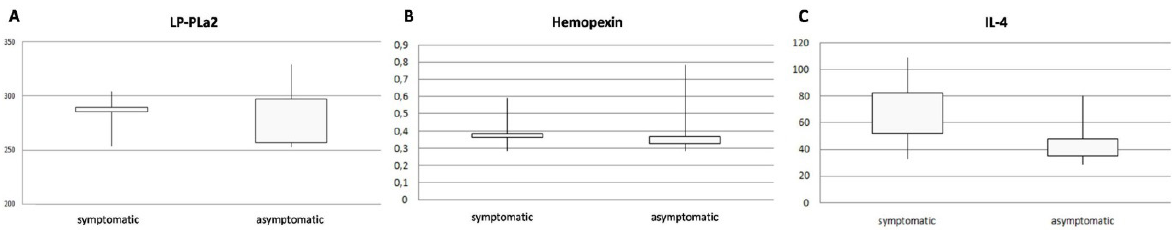
Figure 1: Correlation between plasma levels of biomarkers and neurological symptoms.